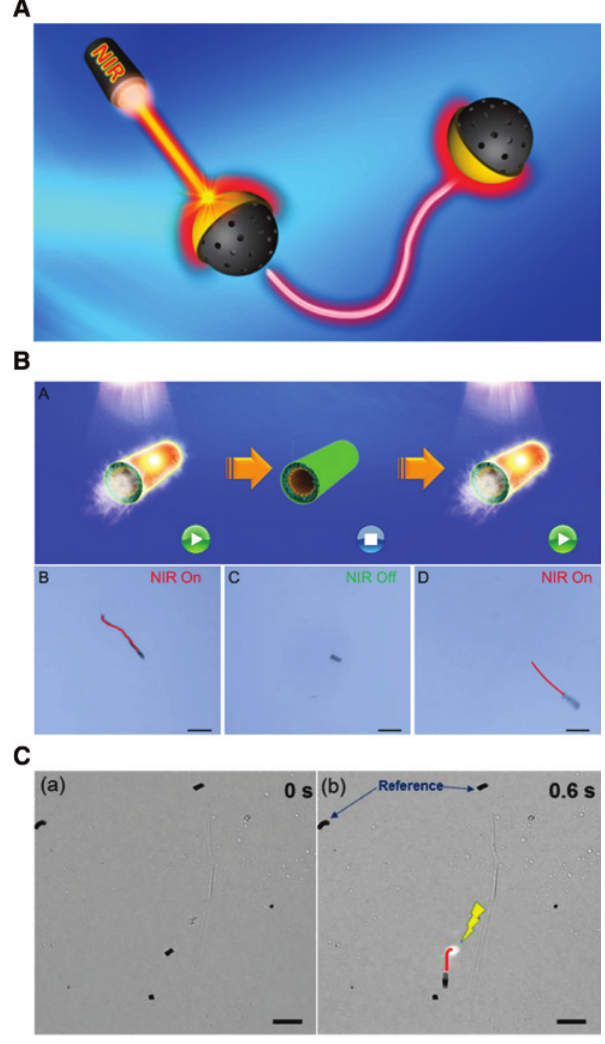
Figure 12: Micro/nanomotors actuated with NIR light. (A) Schematic